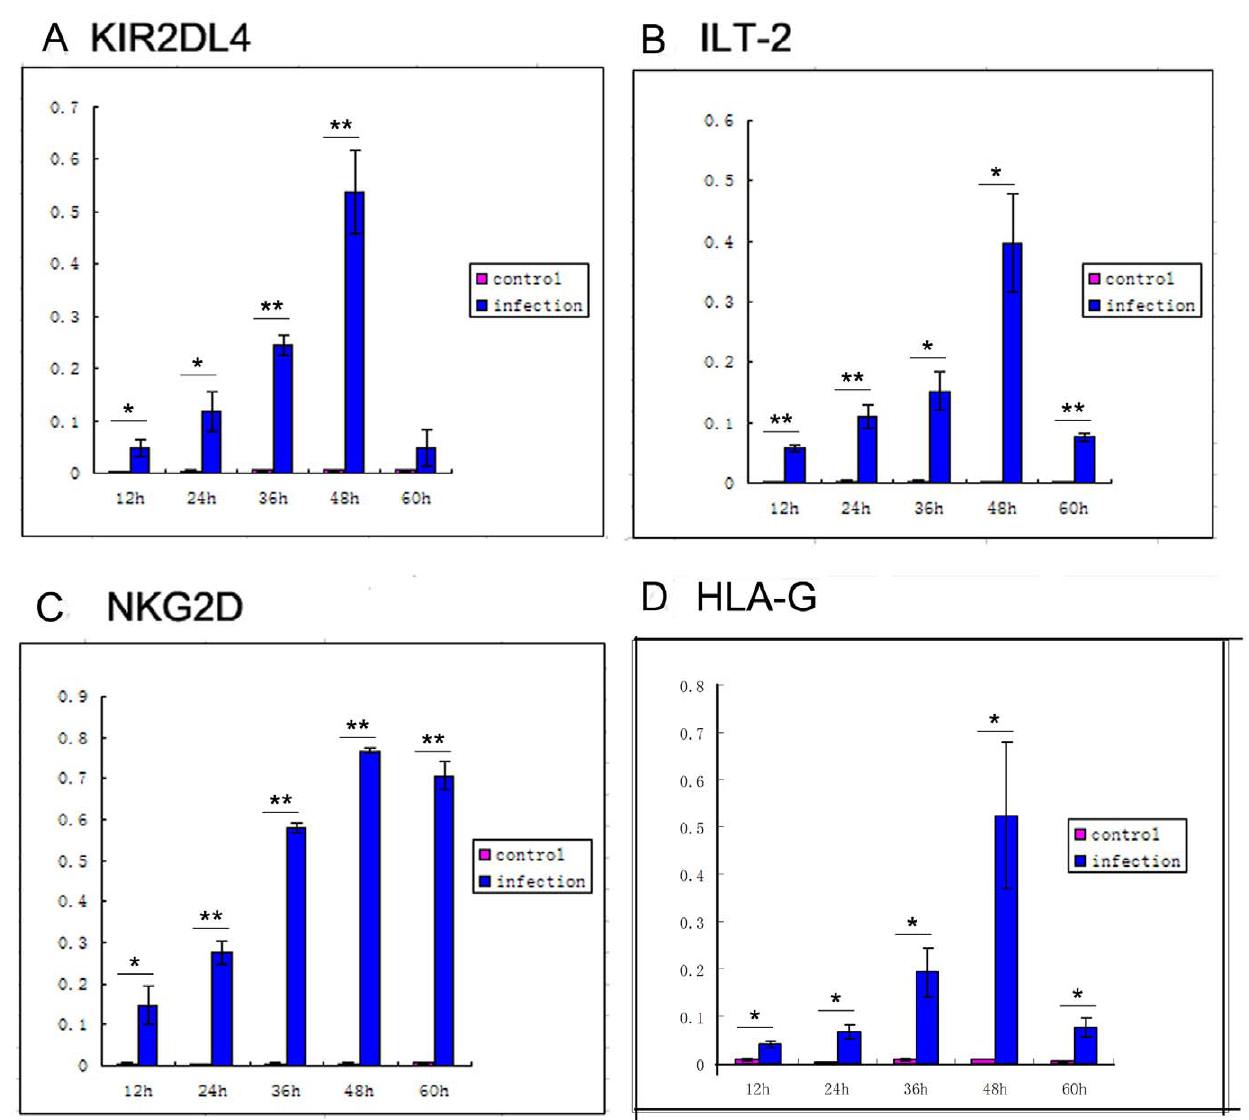
Figure 2. Levels of mRNA. The levels of (A) KIR2DL4 and (B) ILT-2 , (C) NKG2D , and (D) HLA-G mRNAs were measured by real-time PCR. Levels of all four receptors were significantly increased on infected cells compared to those on control cells at 12 h, 24 h, 36 h, 48 h, and 60 h. The magnitude